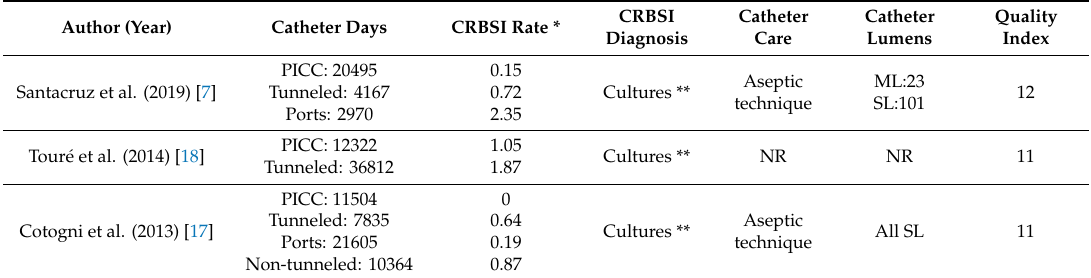
Table 2. Catheter-related bloodstream infections and quality of